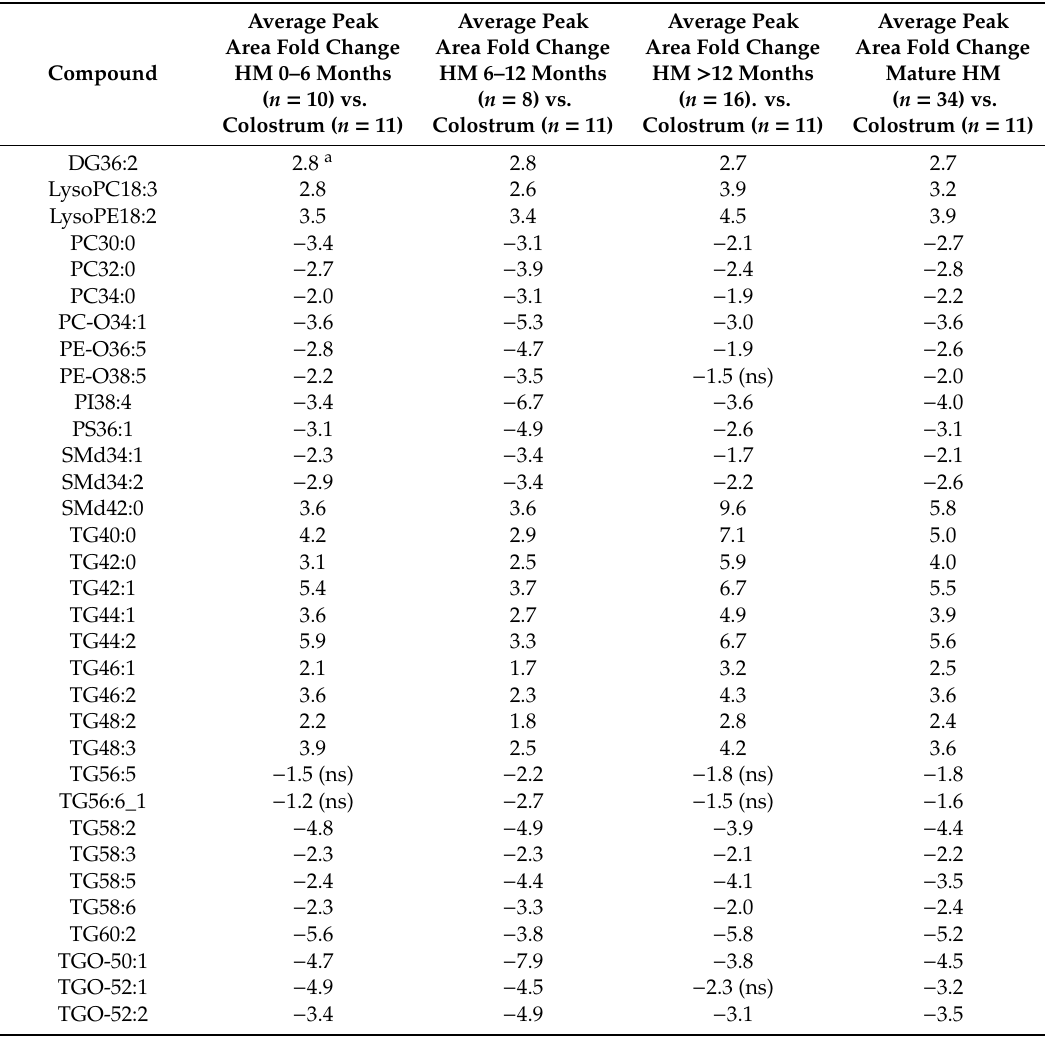
Table 1. Lipids statistically significantly di ff erent between the colostrum and further lactation stage samples (ANOVA unequal variance test, p < 0.01, multiple testing correction: Benjamini–Hochberg, colostrumversusHM0–6months, versusHM6–12months, andversusHM > 12months. Mann–Whitney test, p < 0.01, multiple testing correction: Benjamini-Hochberg, colostrum vs. mature HM (lactation stages other than colostrum considered as a mature HM)). The complete list is presented in the Supplementary Materials in Tables S8 and